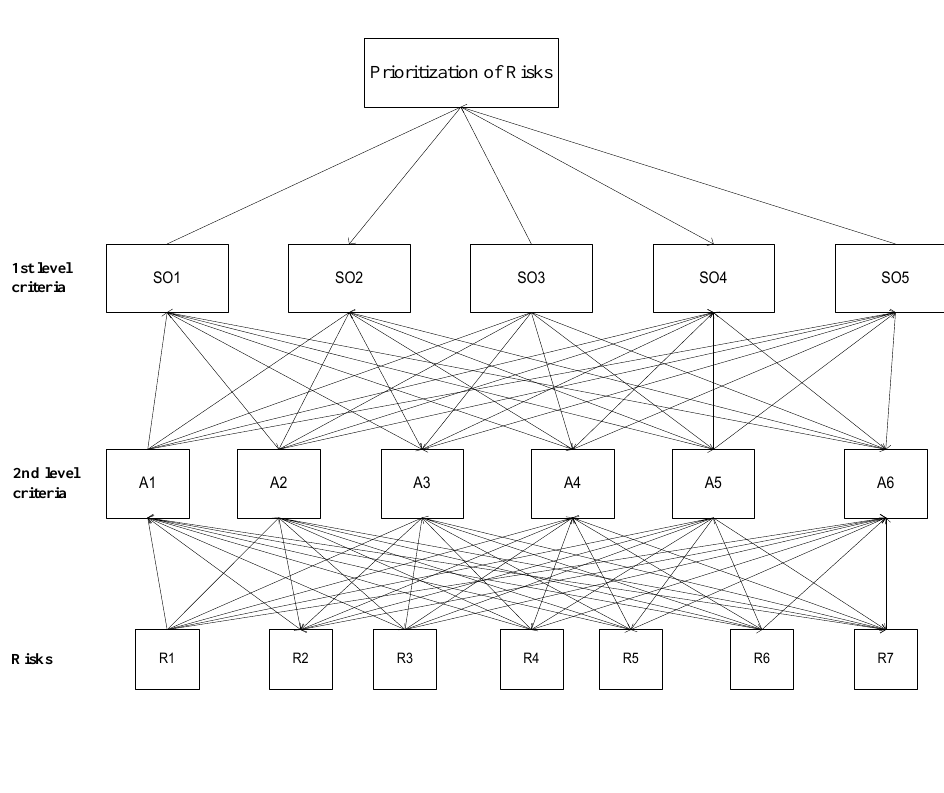
Fig. 1. Hierarchical structure for the prioritization of